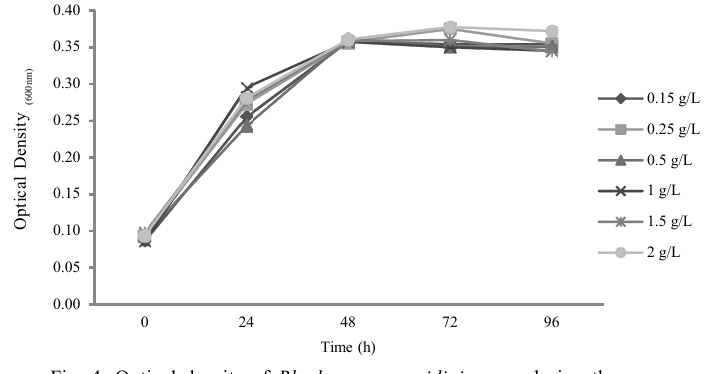
Fig. 4: Optical density of Rhodococcus pyridinivorans during the experiment under different urea concentrations